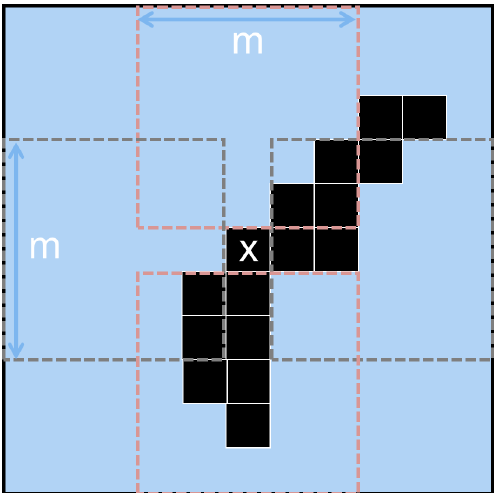
Figure 3. The local estimation method triggers a batch if any of the four regions of size m (red- and gray-dotted) surrounding the most recent event (center X ) contains more than m 2 T le pixels that have been triggered by previous events (black squares). In low-noise conditions, the criteria will be met when an edge passes through any of the dotted regions, accumulating events of more than one-pixel